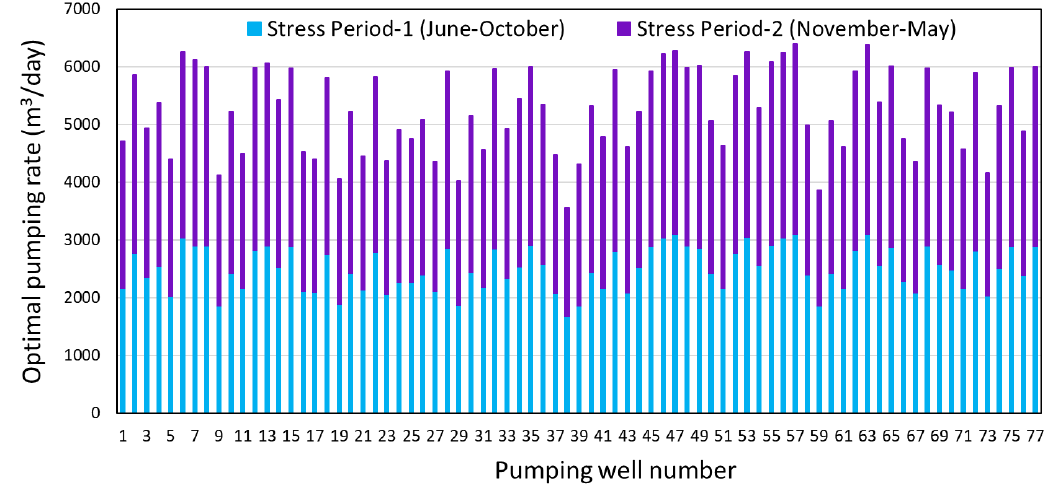
Figure 6. Monsoon season (Stress Period-1) and non-monsoon season (Stress Period-2) optimal pumping rates for the existing 77 wells in 2009, obtained from S-OGM.